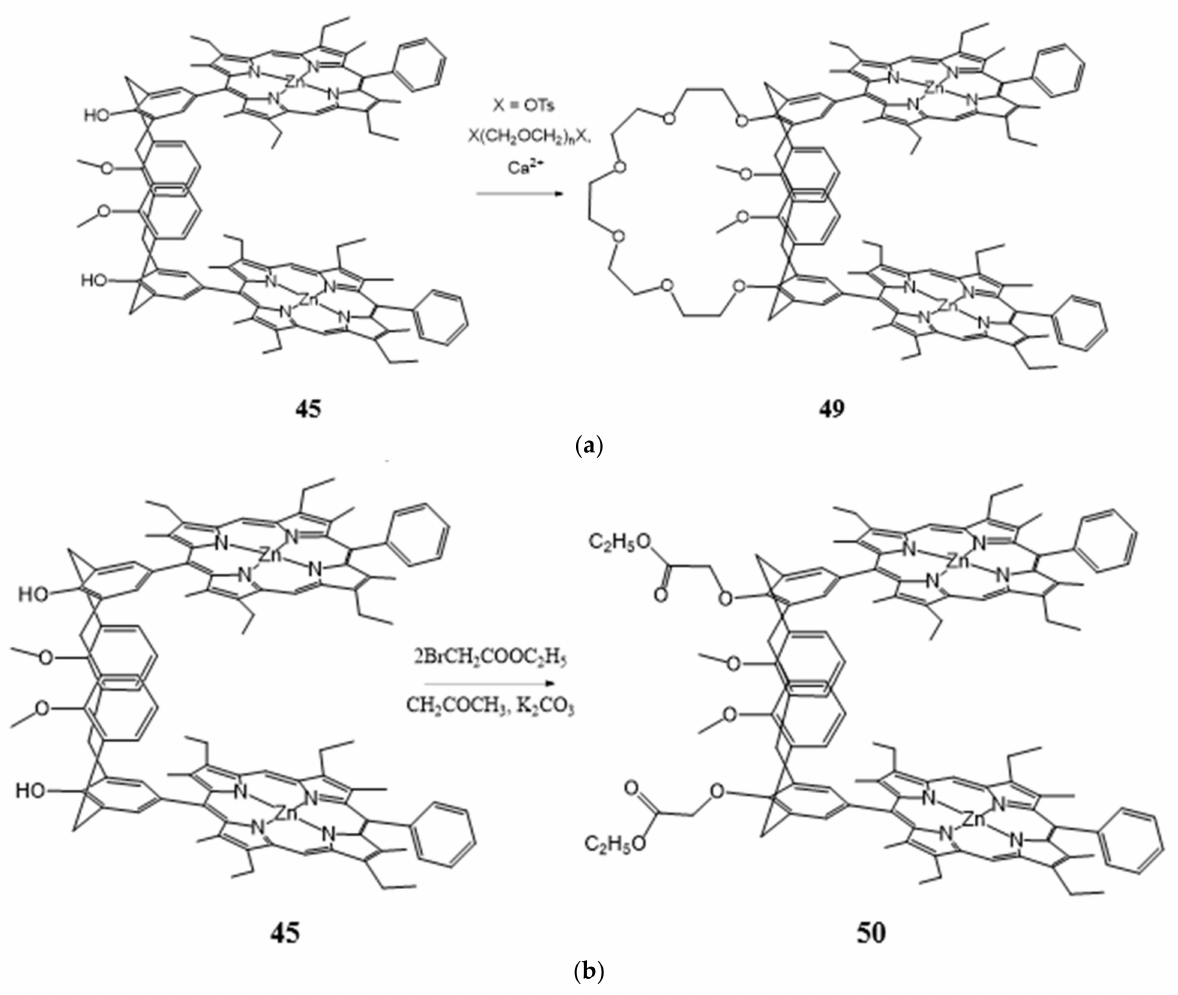
Scheme 12. ( a ) Synthesis of the Bis-porphyrin-calix[4]arene-crawn-[6] ( 49 ); ( b ) Synthesis of the ethoxycarbonyl-substituted Bis-porphyrin-calix[4]arene ( 50